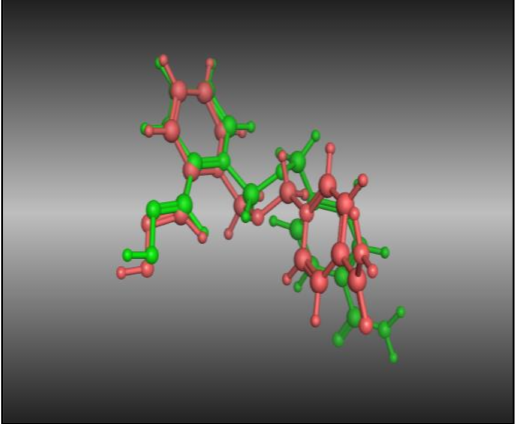
Figure 2. Dark pink: co-crystallized ligand; green: dock ligand.